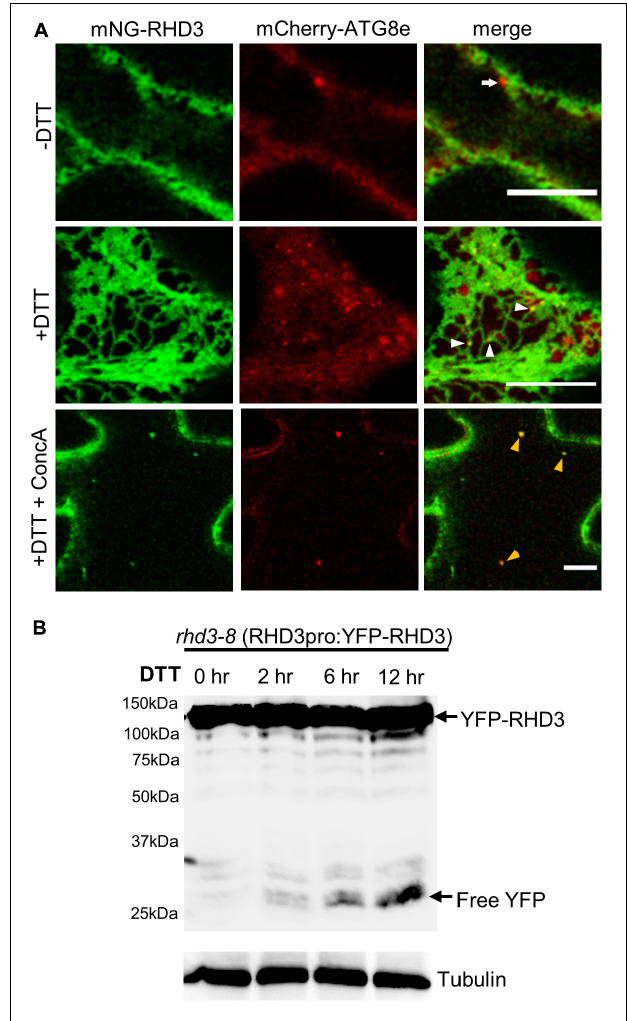
FIGURE 4 | ROOT HAIR DEFECTIVE3 (RHD3) is increasingly associated with autophagosomes under ER stress. (A) The association between RHD3 and mCherry-ATG8e-labeled autophagosomes without or with 10 mM DTT treatment. The arrow in the upper panel points to an autophagosome adjacent to mNeonGreen-RHD3 in a cell without the DTT treatment, while the arrowheads in the middle panel point to the increased association of mNeonGreen-RHD3 with autophagosomes in a cell treated with DTT. Yellow arrowheads in the lower panel point to mNeonGreen-RHD3 together with mCherry-ATG8e-labeled autophagosomes in the vacuole. Scale bars = 10 µ m. (B) Western blot of YFP-RHD3 in rhd3-8 plants expressing YFP-RHD3 driven by the RHD3 native promoter treated with 10 mM DTT for different hours